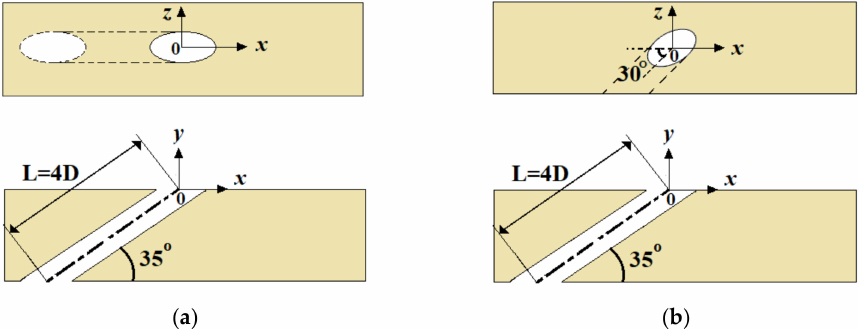
Figure 1. Details of the cylindrical hole configuration used with orientation angle β of 0 ◦ and 30 ◦ . ( a ) β = 0 ◦ ; top: top view, bottom: side view; ( b ) β = 30 ◦ ; top: top view, bottom: side